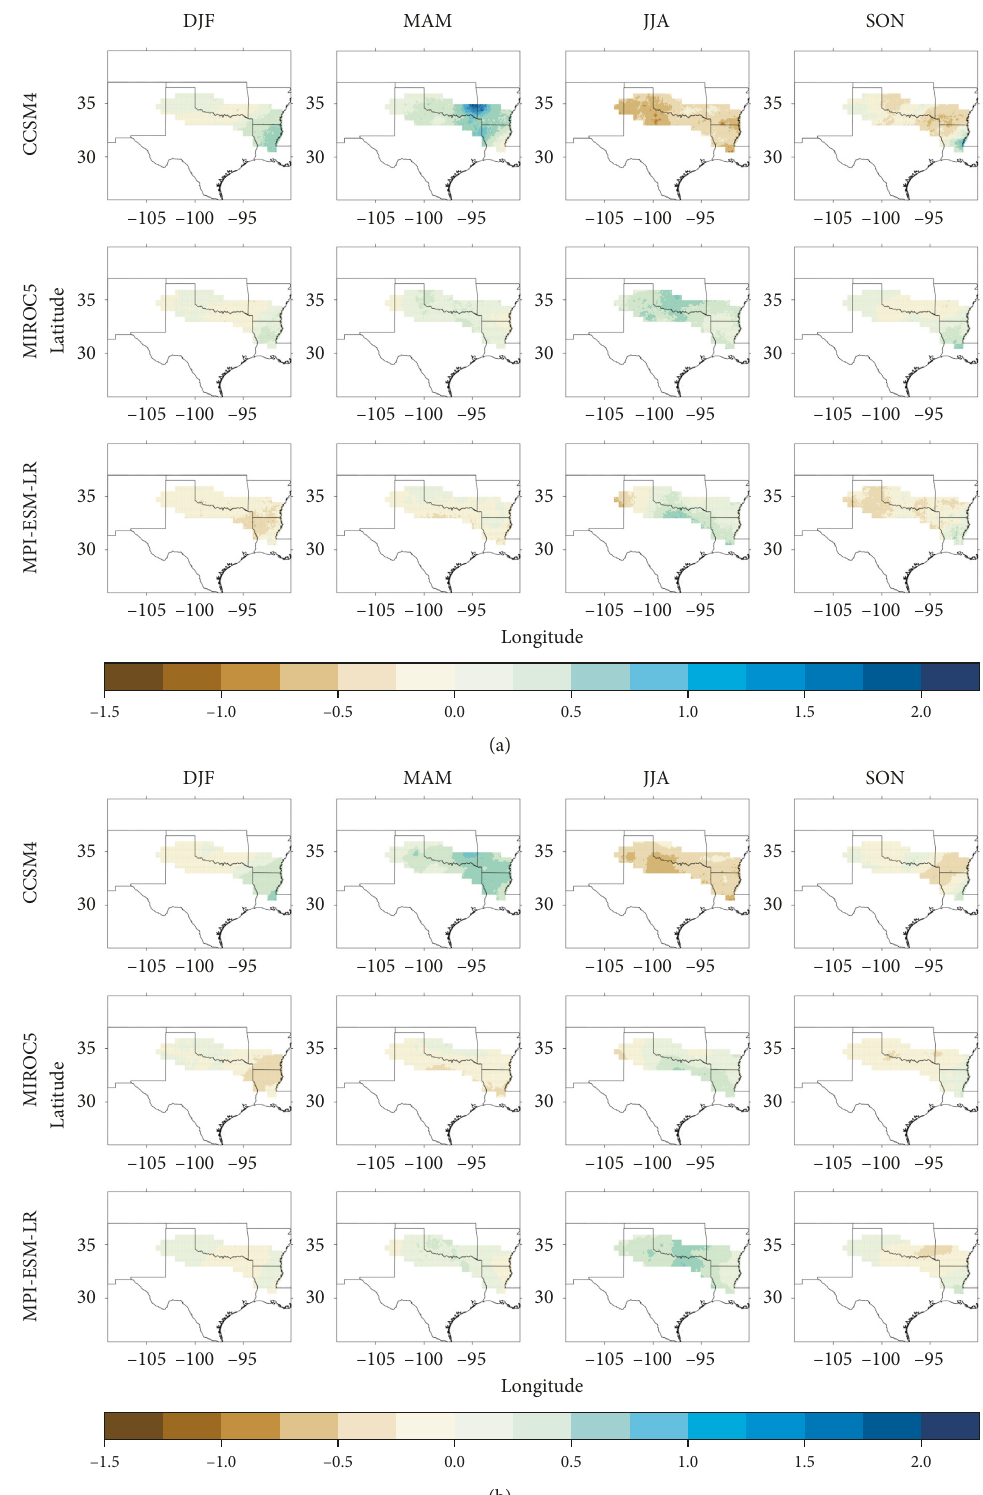
Figure 8: Difference field in seasonal changes in mean daily precipitation (mm/day) between the historical (1981–2005) and mid-century (2046–2070) time frames for RCP 2.6 using the (a) CDFt downscaling technique and (b) EDQM technique. Columns represent seasons (DJF, MAM, JJA, and SON). Brown colors represent a decrease in daily precipitation and blues represent an